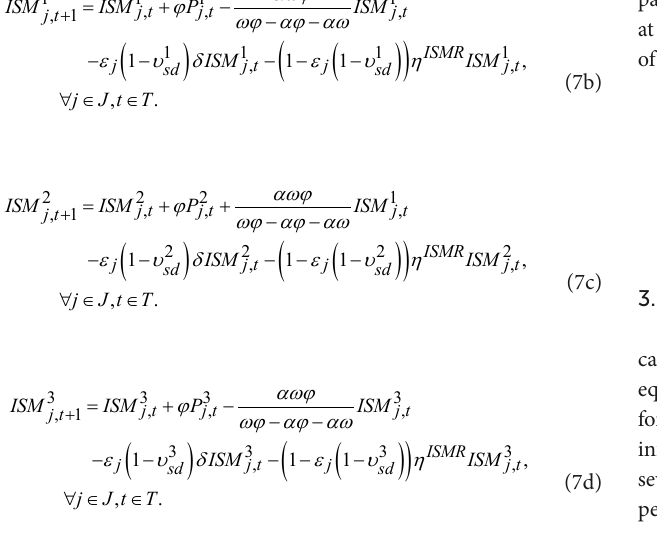
According to Equation (9), the number of infected-hospitalized cases in the ICU for age group j at the end of period t + 1 is equal to the number of infected-hospitalized cases in the ICU for age group j in the previous period plus the number of newly infected-hospitalized cases in the ICU transferred from severely-symptomatic infectious individuals for age group j at the time period t , minus the number of infected-hospitalized cases in the ICU for age group j who recovered or died while on therapy at the time period t , where ψ j is the proportion of hospitalized cases of age group j who required ICU and γ j is the proportion of ICU cases of age group j who died. The parameter 1/ η tICUR represents the mean recovery time of ICU cases at time period t , and the parameter 1/ ζ tICUD denotes the mean time of ICU cases who died at time period